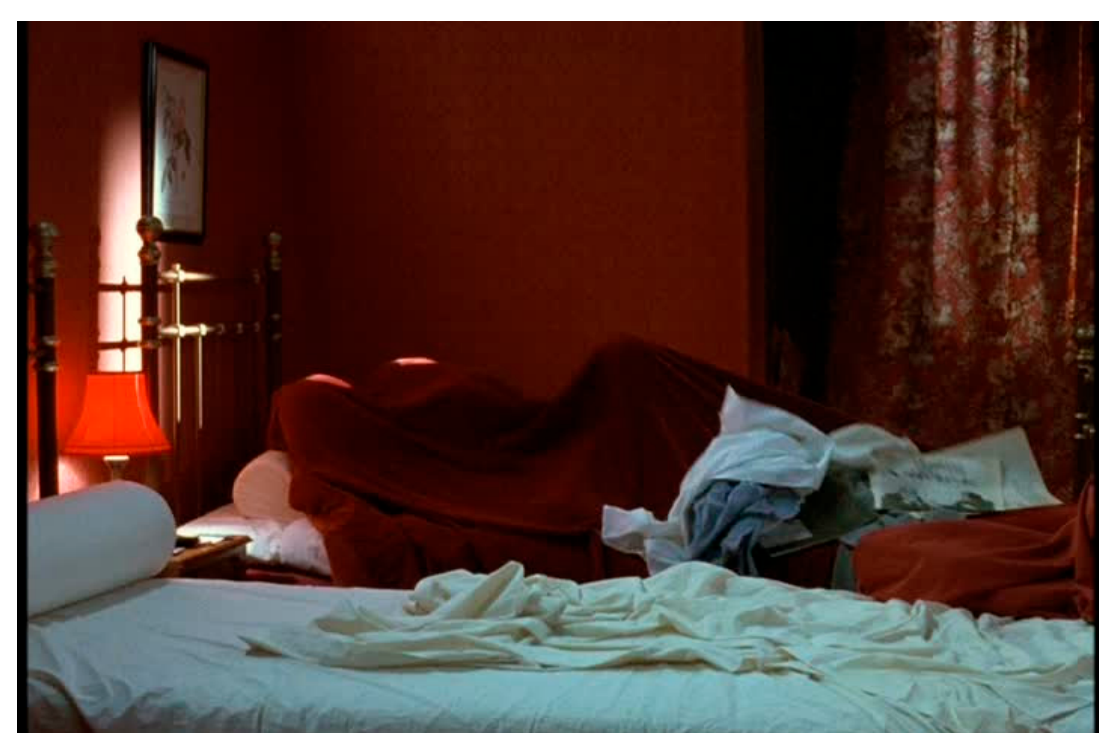
Figure 7. …to sleep.